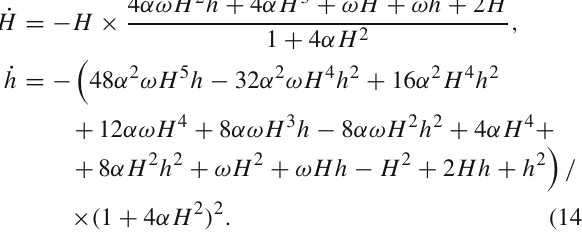
ω < 1 / 3 on (b) panel and ω > 1 / 3 on (c) panel. Green line ˙ ˙ h = 0 while black to H = 0 (see (14)). Dark corresponds to blue area corresponds to unphysical ( H , h ) pairs with ρ <